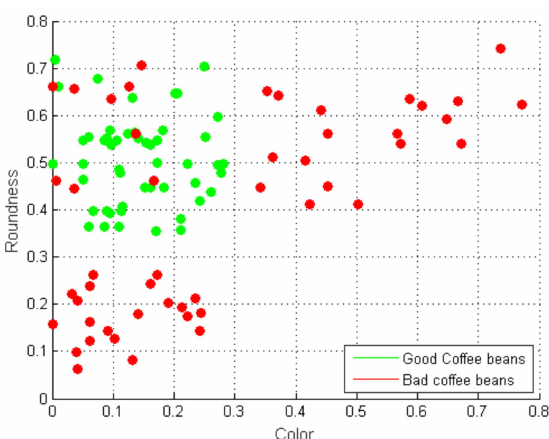
Figure 10. Experimental set-up.